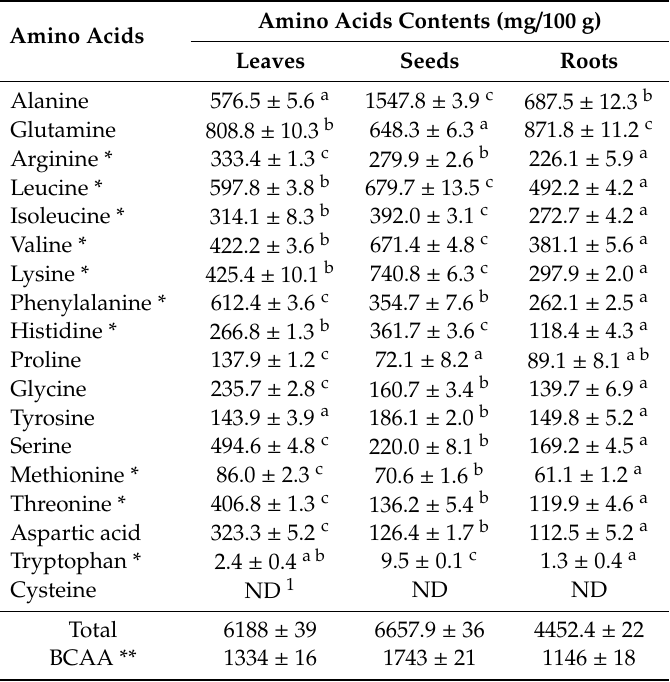
Table 2. The amino acids composition of leaves, seeds, and roots from